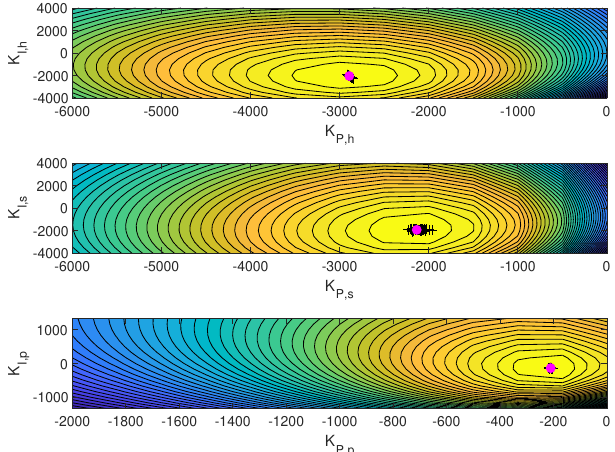
Fig. 17: Gain tunings for 20% uncertainty in the damp- ing term for sea-state